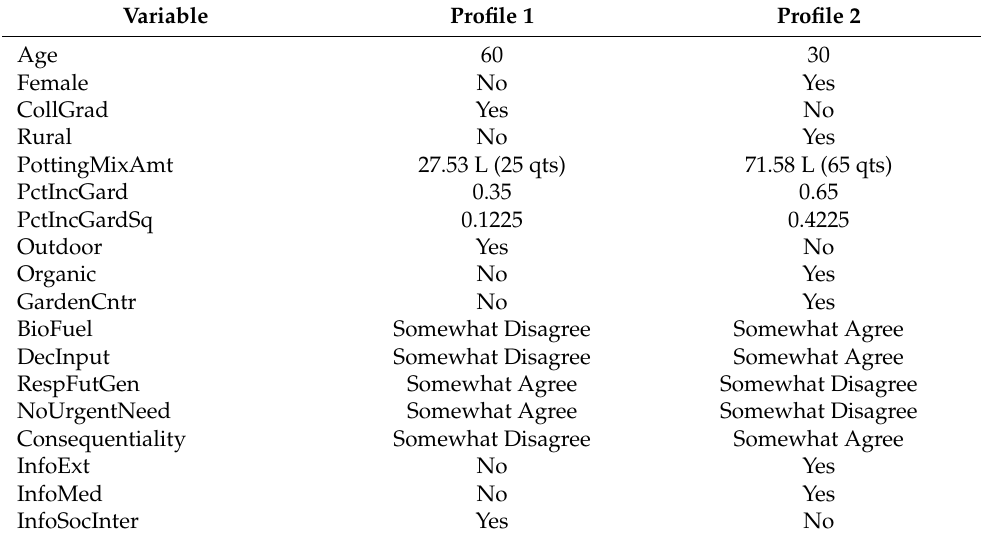
Table 4. Example Home Gardener Profiles for a Low Probability (Profile 1) and High Probability (Profile 2) of